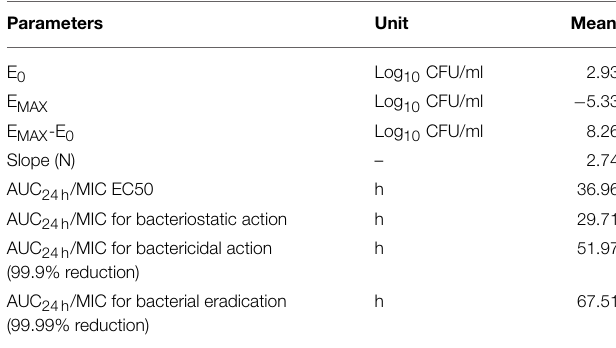
TABLE 4 | Integration of PK/PD data obtained after intra venous administration of Cefquinome (1mg/kg) in cattle ( n = 6 ). Parameter Unit